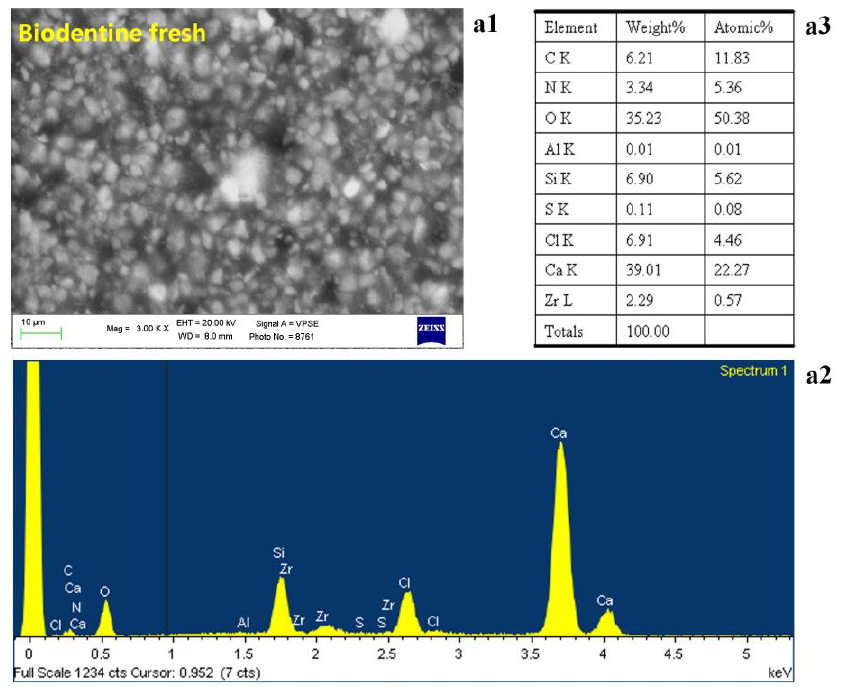
Figure 2. Environmental microscopy and microanalysis of Biodentine soaked in HBSS showing ESEM pictures ( a1 , b1 , c1 ), EDX spectra of the whole area ( a2 , b2 , c2 ), the elemental X-ray microanalysis (compositional weight % and atomic %) ( a3 , b3 , c3 ) and the element mapping ( c5 – c9 ) performed on the 28-day-aged surface ( c4 ). Freshly mixed Biodentine ( a1 ) showed a uniform surface containing interspersed granules approx 5 microns wide, and mainly displayed Ca, Si, Zr, and Cl reflexes ( a2 ). With soaking time in HBSS ( b1,c1 ), a layer of globular CaP precipitates formed on the surface, the reflexes of N and Zr disappeared, the Si component decreased in intensity and Na, Mg, and P elements from HBSS became detectable ( b2 ). The intensity of P reflexes increased with the soaking time ( b2,c2 ) and consequently the Ca/P atomic ratio decreased ( b3,c3 ). At 28 days, the Ca/P atomic ratio was approximately 2.5 ( c3